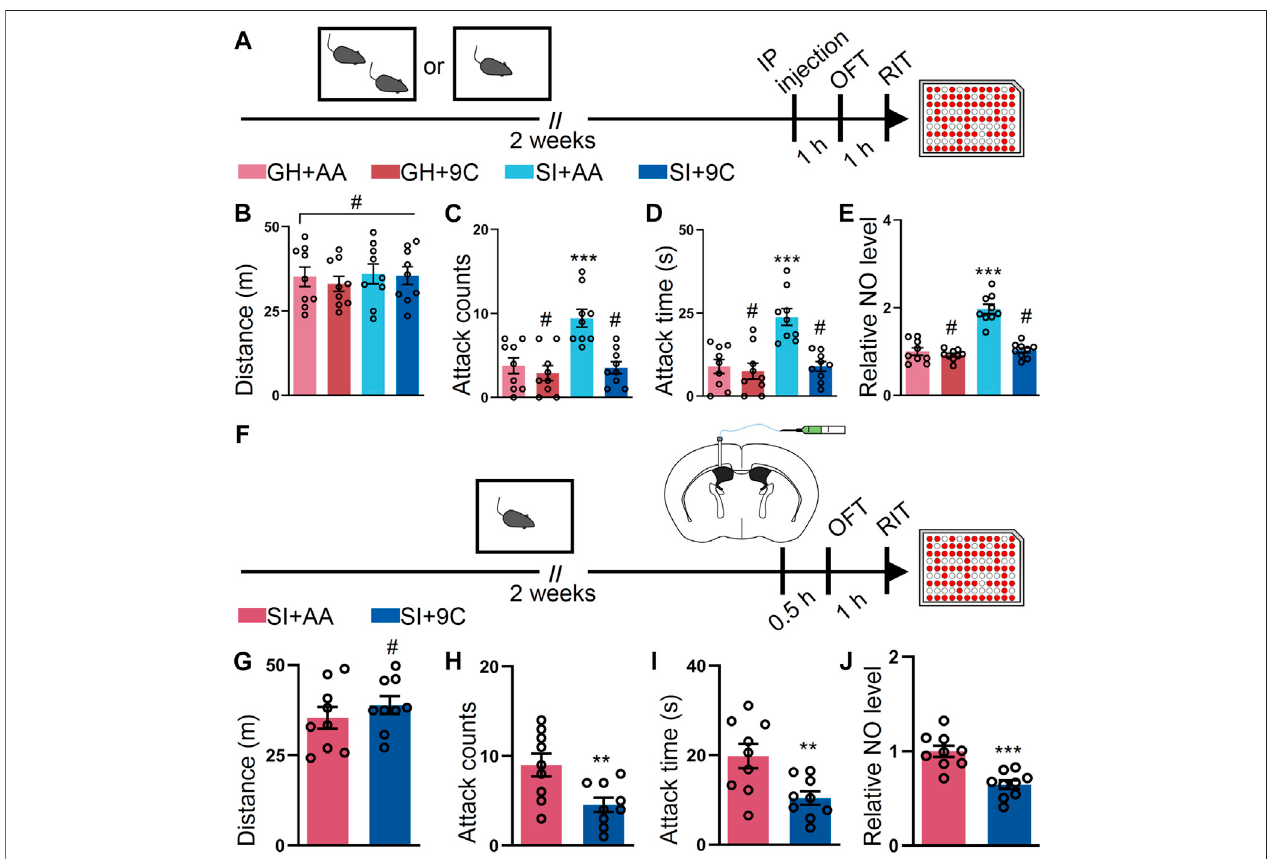
FIGURE 2 | TAT-9C peptide targeting GluN2B-containing NMDA receptor ameliorates the SI-induced escalated attack behavior. (A) Time course of the experiments. (B) Totaldistanceofmicetreatedasshownin (A) duringtheOFT(F 3,32 (cid:1) 0.2299, p (cid:1) 0.8748). (C) Attackcountsofmicetreatedasshownin (A) duringthe RIT (F 3, 32 (cid:1) 11.16, p < 0.001). (D) Attack duration of mice treated as shown in (A) during the RIT (F 3, 32 (cid:1) 12.85, p < 0.001). (E) The relative NO level of the cortex from mice treated as shown in (A) (F 3, 32 (cid:1) 41.40, p < 0.001). (F) Schematic illustrating the experimental procedure. The mice were implanted with a guide cannula and singlyhousedfor2 weeks.Afterward,TATpeptidewasinjected via theICVroute,andbehavioraltestswereperformed. (G) Totaldistanceofmicetreatedasshownin (F) duringtheOFT(t 16 (cid:1) 0.9012, p (cid:1) 0.3808). (H) Attackcountsofmicetreatedasshownin (F) duringtheRIT(t 16 (cid:1) 2.961, p (cid:1) 0.0092). (I) Attackdurationofmicetreatedas shownin (F)